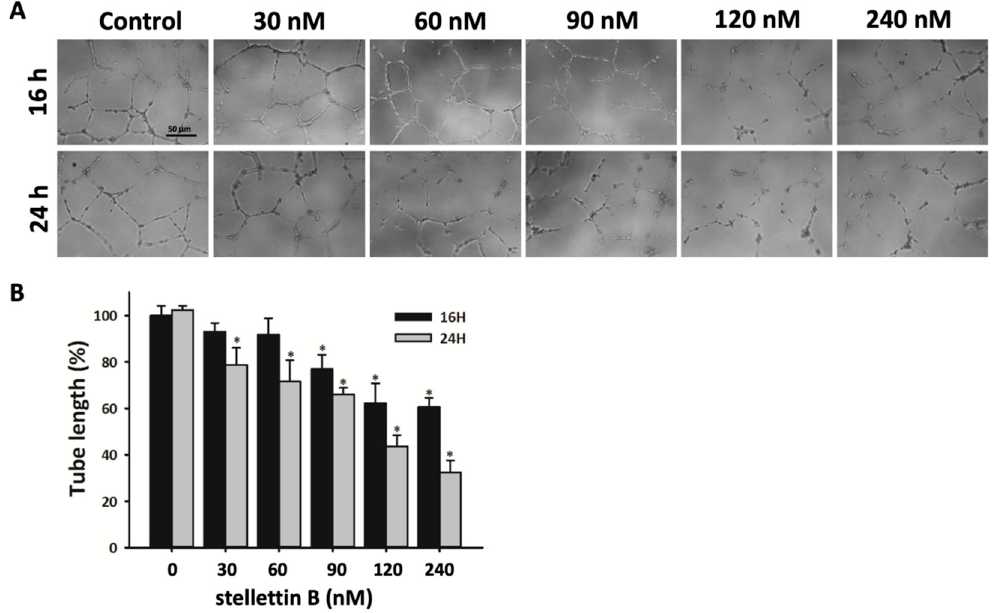
Figure 6. Effect of stellettin B on HUVEC tube formation. ( A ) HUVECs were plated in Matrigel-coated wells and treated with 0, 30, 60, 90, 120, or 240 nM stellettin B. Tube formation was assessed and photographed at 16 and 24 h. Scale bar = 50 µ m. ( B ) The vessel length was measured for each treatment condition. Results are representative of three separate experiments and are expressed as mean ± SD ( n = 3). * p < 0.05 relative to controls.